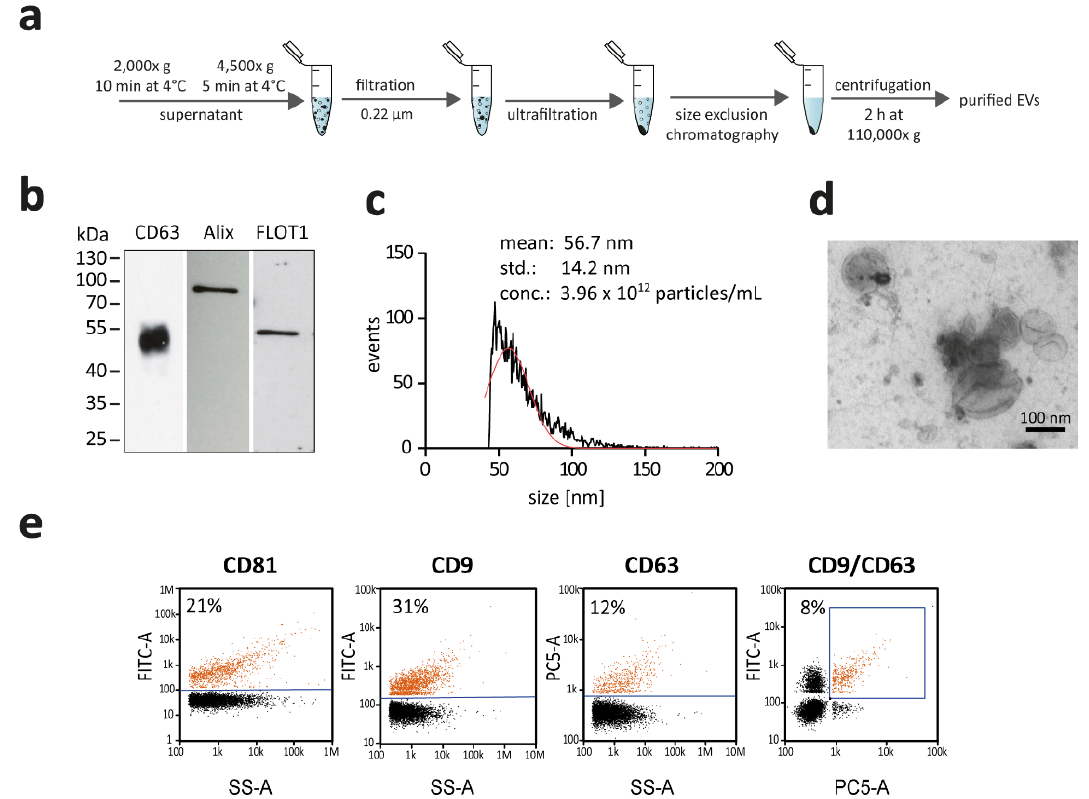
Figure 1. Isolation and characterization of extracellular vesicles from HEK293 cells. ( a ) Schematic overview of EV purification from cell culture supernatant. EVs were purified by a combination of differential centrifugation steps, followed by ultrafiltration and size exclusion chromatography. The EV-containing fractions were pooled and subjected to a final ultracentrifugation step. Subsequently, the EVs were resuspended in PBS. ( b ) Western blot analysis of EV-marker proteins CD63, ALIX, FLOT1. ( c ) Nano-flow cytometry (NanoFCM) analysis, depicting the size distribution (diameter) and concentration of particles and indicating mean and standard deviation (std.) of the size distribution. ( d ) Electron microscopy of purified vesicles. Purified EVs were counterstained by uranyl acetate. ( e ) Single-particle phenotyping of HEK293- derived EVs. EVs were fluorescently labelled with FITC-conjugated antibodies specific to CD81 and CD9 or PE-conjugated CD63. Bivariate dot-plots of indicated fluorescence versus SSC are shown. In addition, double positives for CD9/CD63 are